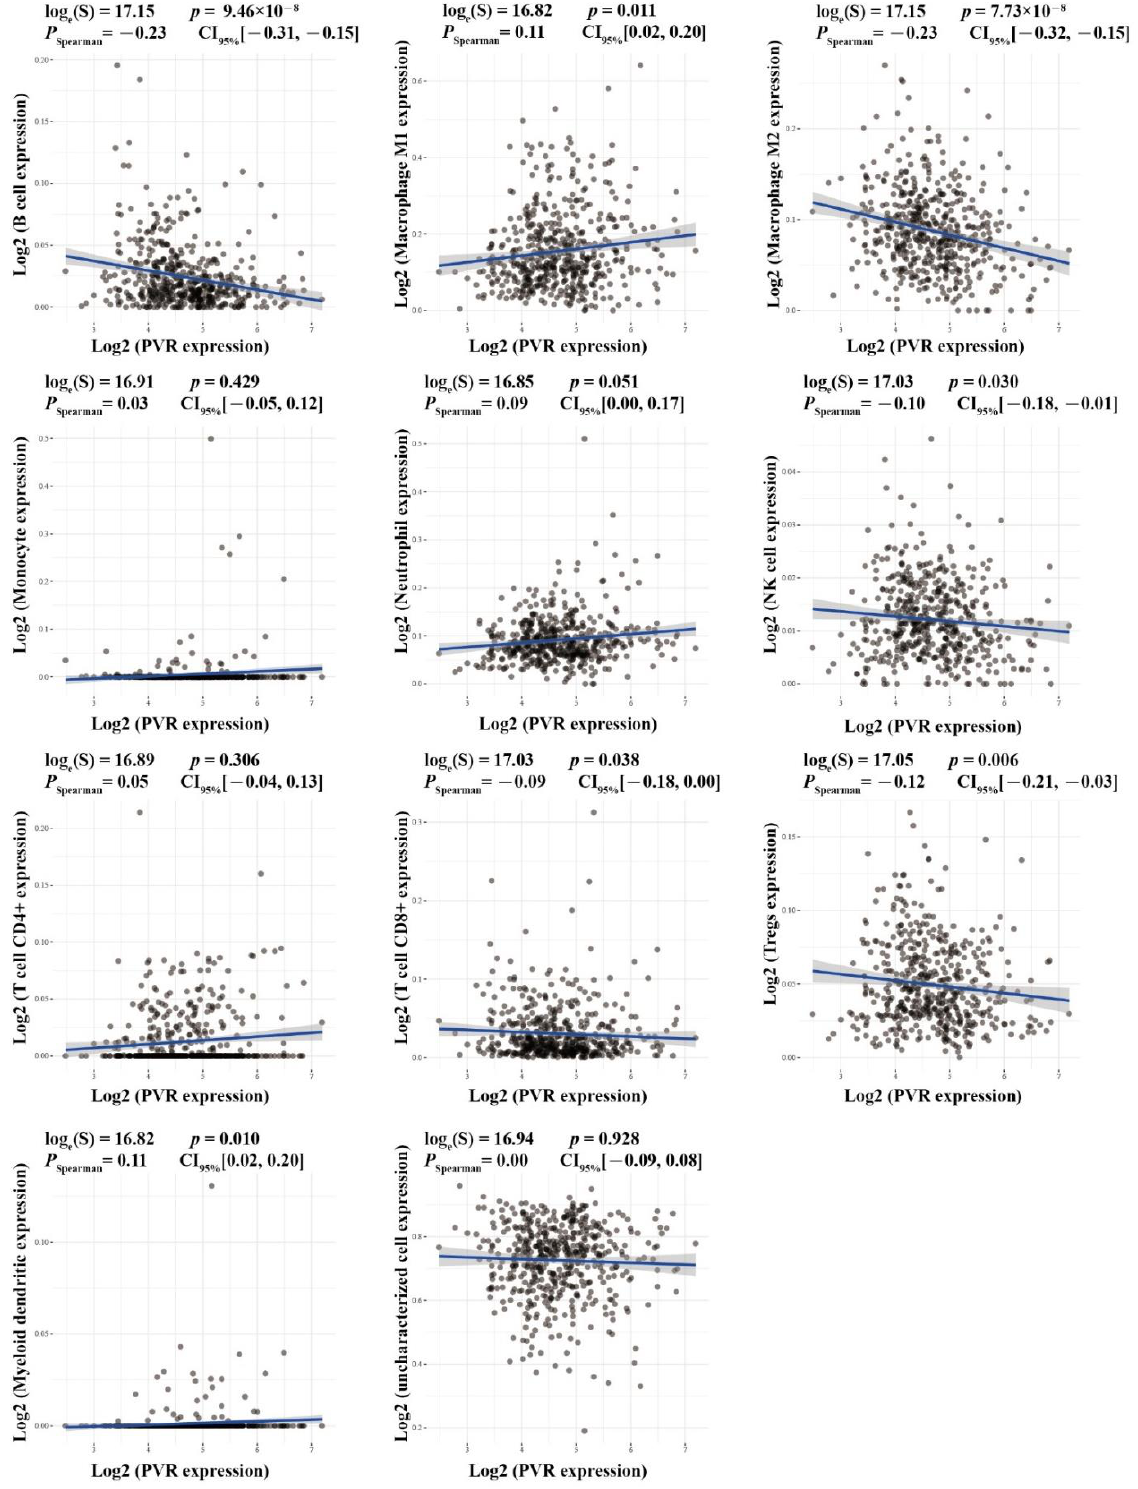
Figure 3. CD155 can be involved in immune infiltration. Immune infiltration analysis was performed in the ACLBI databases.